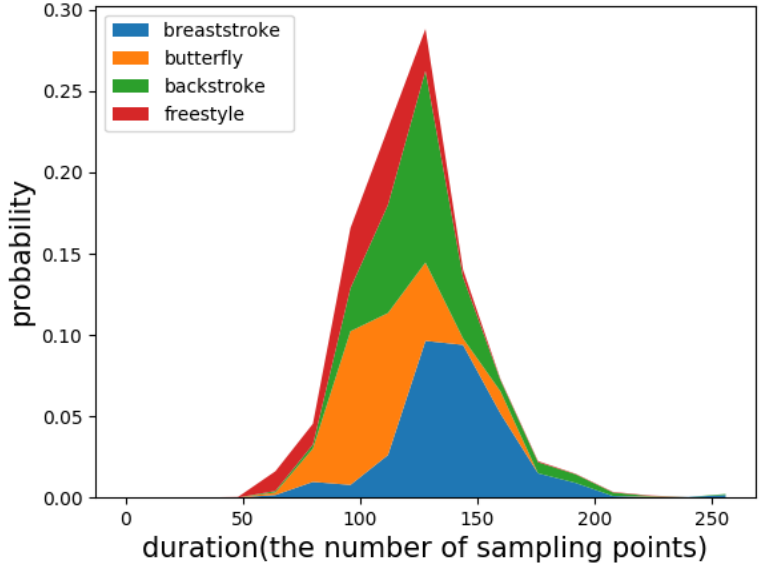
Figure 10. The duration distribution of four strokes.